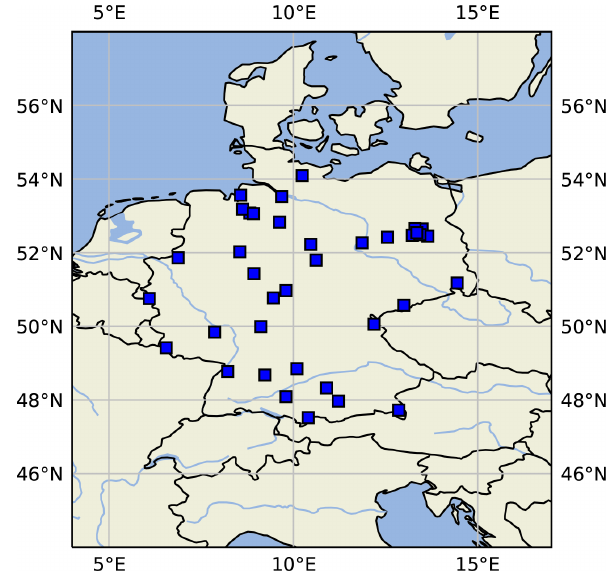
Figure 6. Map of central Europe showing the locations of some sample measurement stations as blue squares created by PlotStationMap